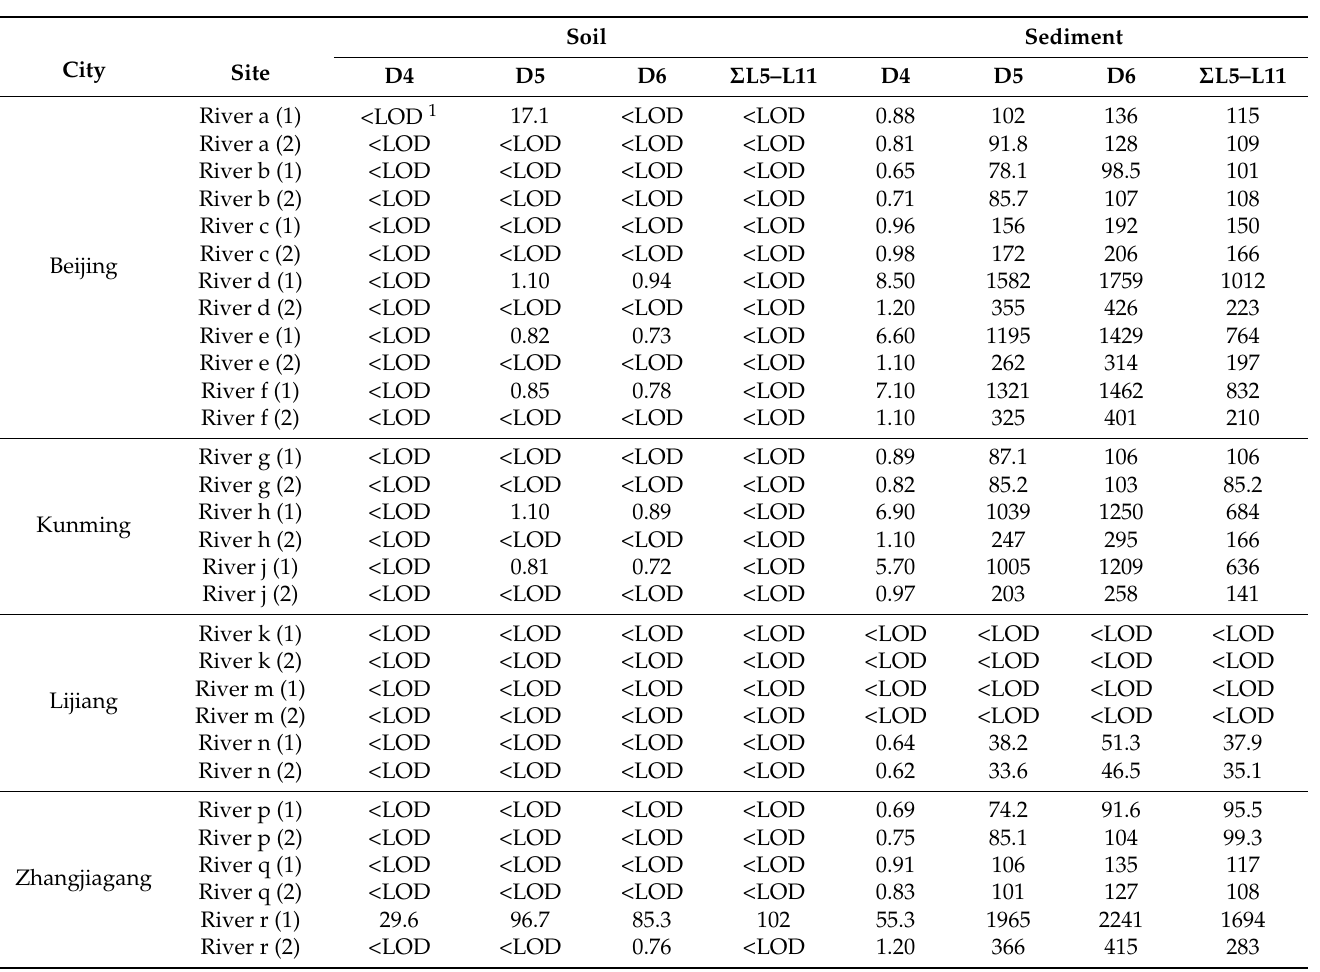
Table 3. The mean concentrations (ng/g dw) of methylsiloxanes in soil and sediment samples from four